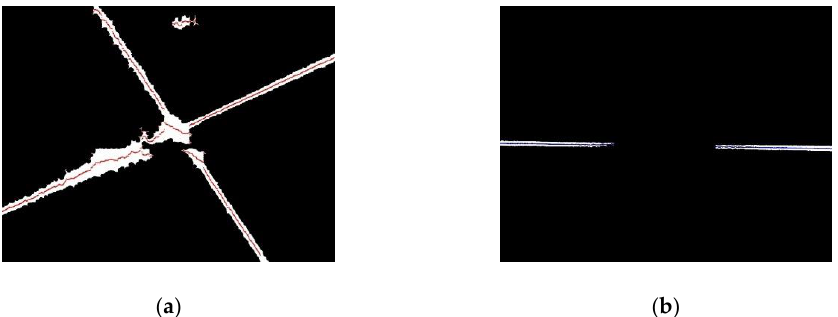
Figure 8. Extracted valid points. ( a ) Laser stripe region. ( b ) Joint region.